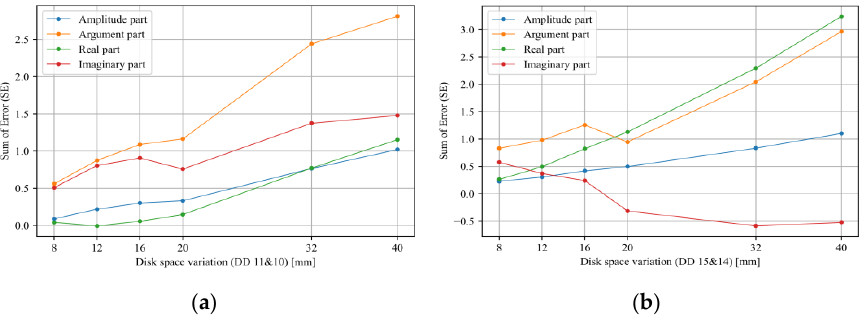
Figure 17. Feature variations based on the severity of the DSV fault in different locations for extracted by the SE index: ( a ) DSV in DD 11 and 10 ( b ) DSV in DD 15 and 14.